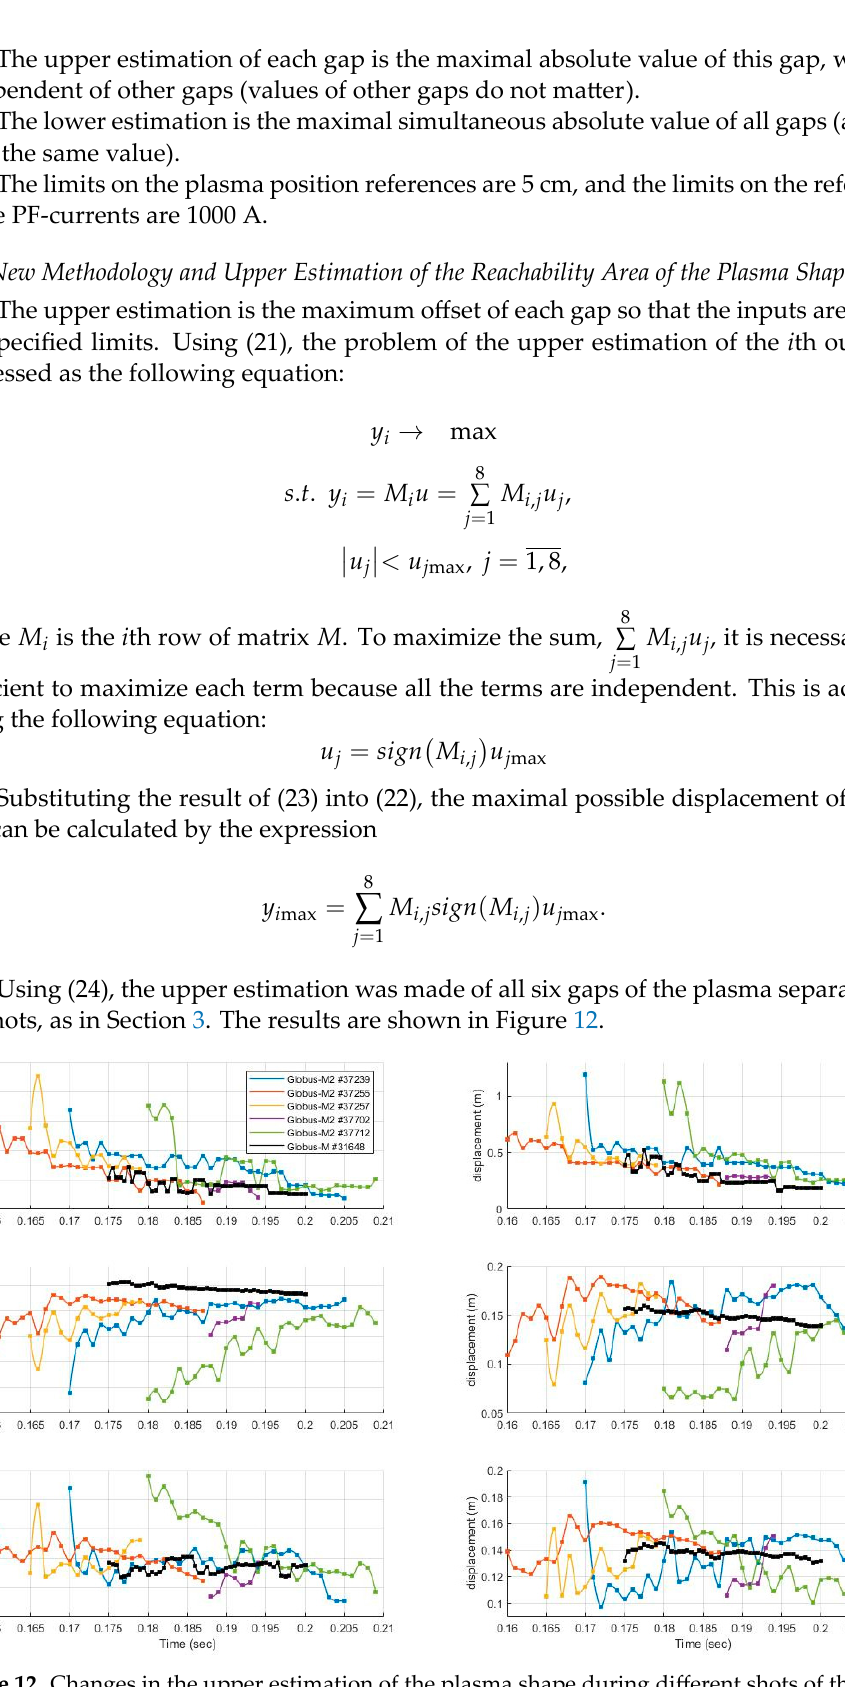
Figure 12. Changes in the upper estimation of the plasma shape during different shots of the spher‑ ical Globus‑M/M2 tokamaks.